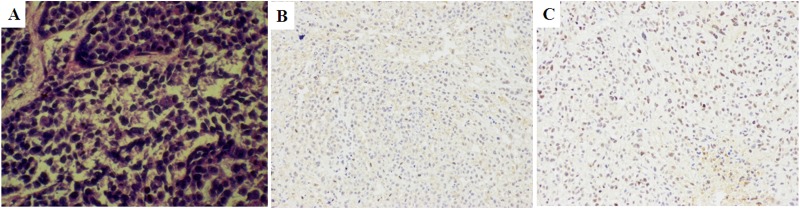
Representative photomicrographs of histological and immunohistochemical features.(A) H&E staining of an SKOV3 tumor 400 ×; (B) IHC staining of an SKOV3 tumor; (C) IHC staining of a PC3 tumor. The cells with brown granules in the cytoplasm were MMP2-positive.